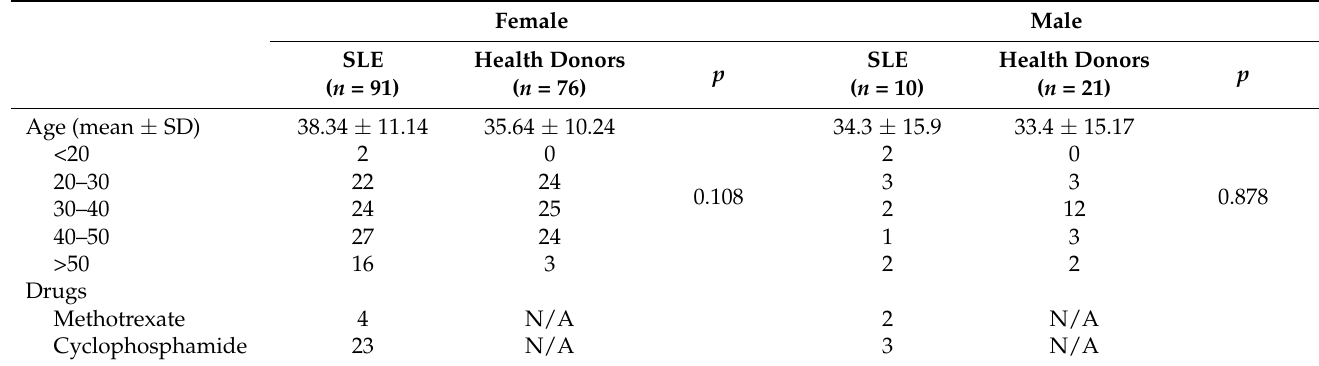
Table 1. Demographic data of systemic lupus erythematosus and healthy donors.